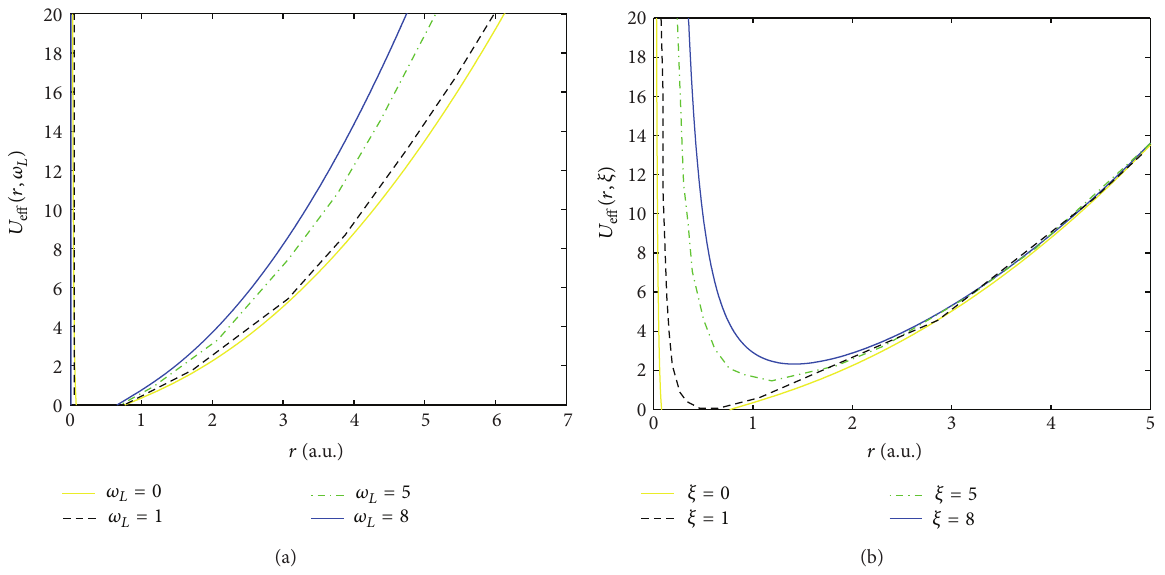
Figure 1: The KG effective potential function for (a) 𝜔 𝐿 = 0,1,5,8 and with 𝜉 = 0 . (b) 𝜉 = 0, 1, 5,8 and with 𝜔 𝐿 = 0 (colour online). Here, = ℎ = 𝑐 = 1 𝑚 𝑒